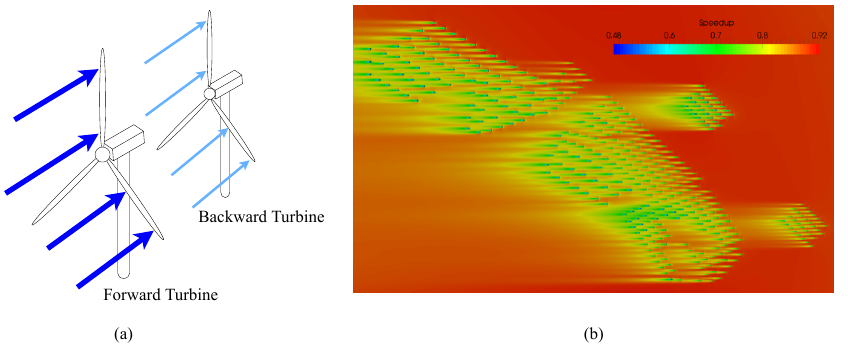
Figure 8. ( a ) A schematic of the wake effect for two WTs. ( b ) CFD results showing wake effects in an offshore wind farm [45], reproduced with permission from Abel Gargallo-Peiró. Speedup stands for the velocity at each location divided by the upstream reference